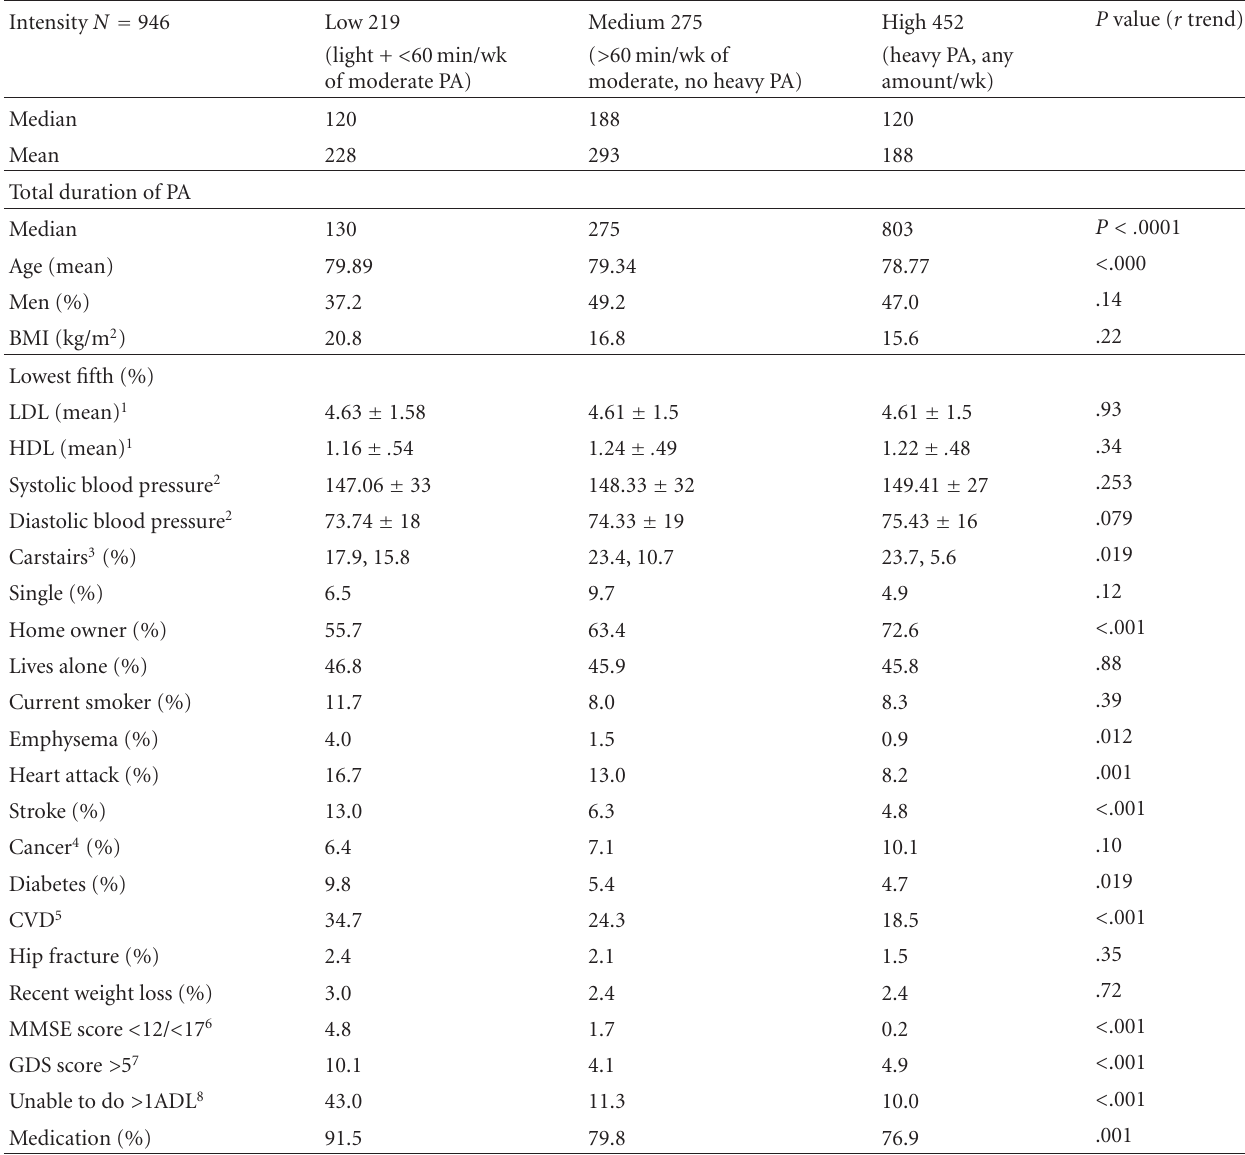
Table 4: Characteristics of the study participants by category of intensity of